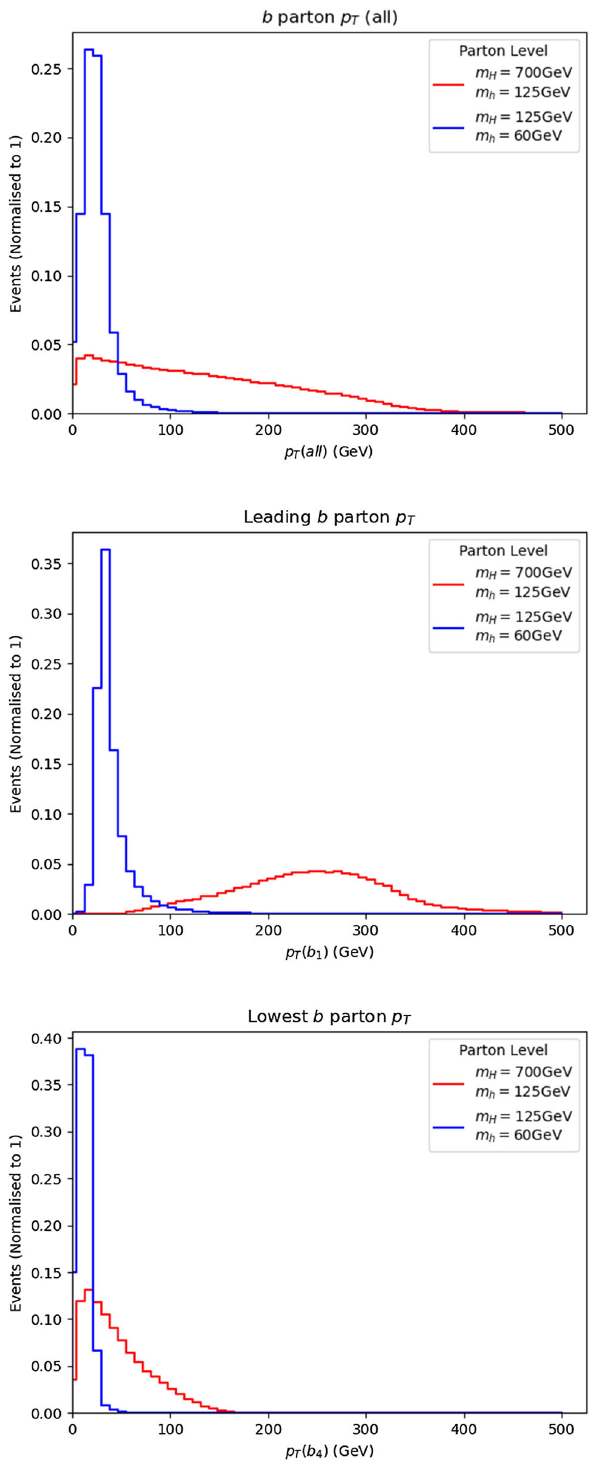
Fig. 7 Upper panel: the p T distribution for all b -quarks. Middle panel: highest p T amongst the b -quarks. Lower panel: lowest p T amongst the b -quarks. No (parton level) cuts have been enforced